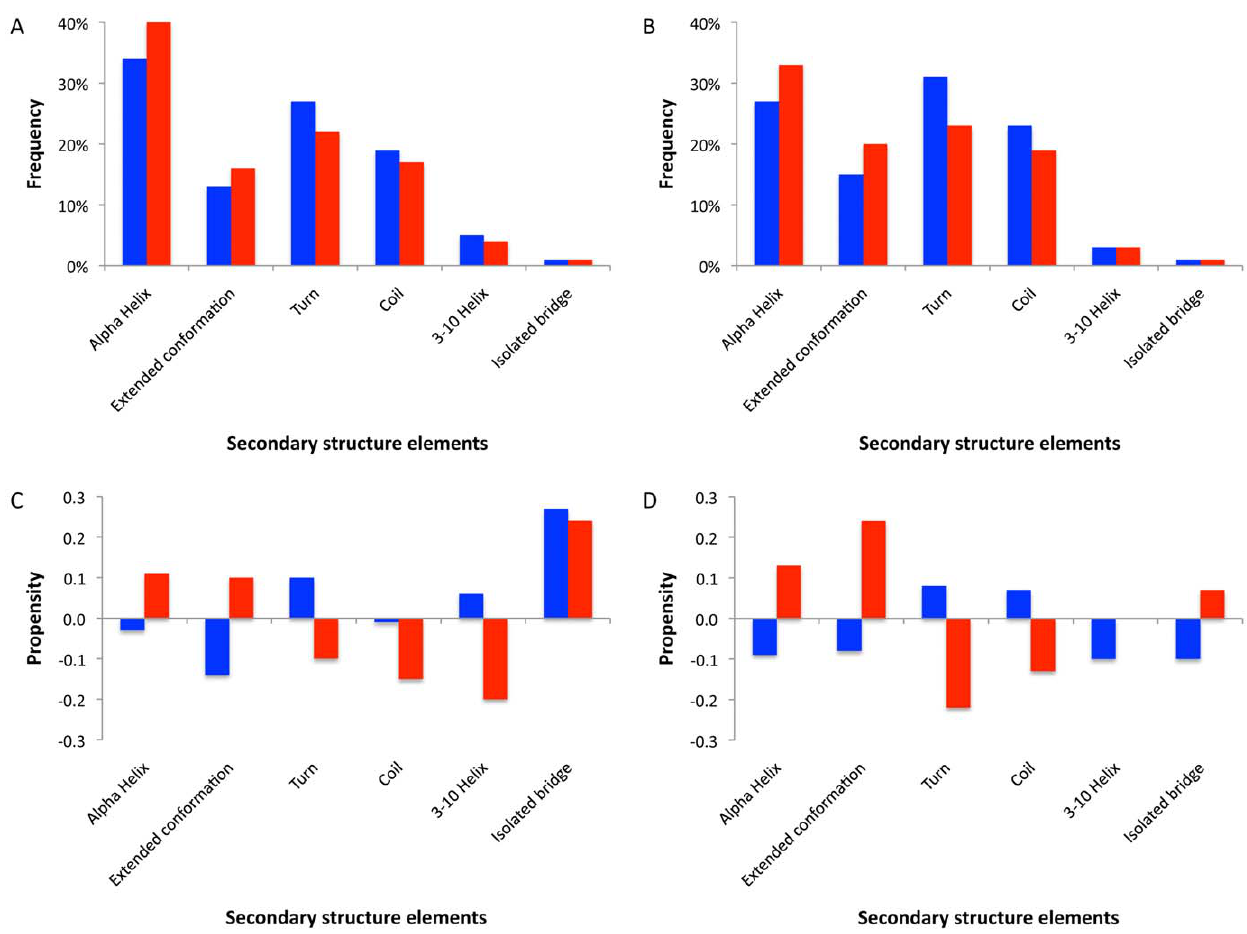
Figure 4. Structural elements in the interfaces. A. Frequency of secondary structure elements in homocomplexes. B. Frequency of secondary structure elements in heterocomplexes. C. Propensities of secondary structure elements to be in the interface in homocomplexes. D. Propensities of secondary structure elements to be in the interface in heterocomplexes. Blue bars correspond to the rim area, whereas red bars correspond to the interacting residues.